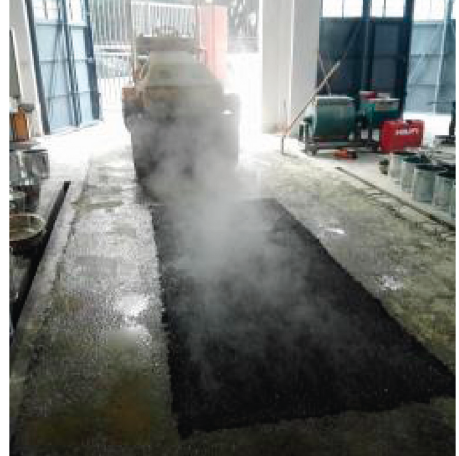
Figure 7: Compacting the hard sandstone asphalt